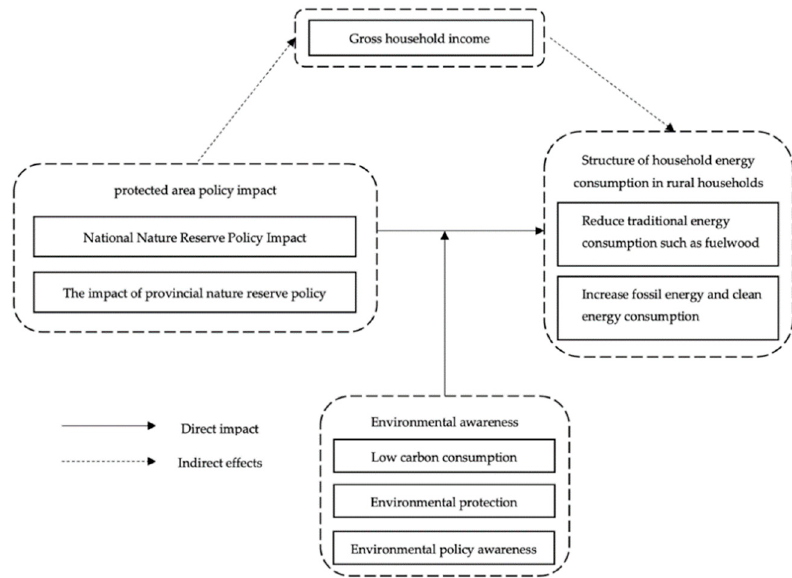
Figure 1. The research framework.